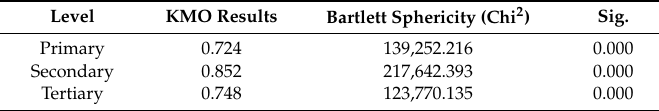
Table 2. Kaiser–Meyer–Olkin (KMO) test results. Source: